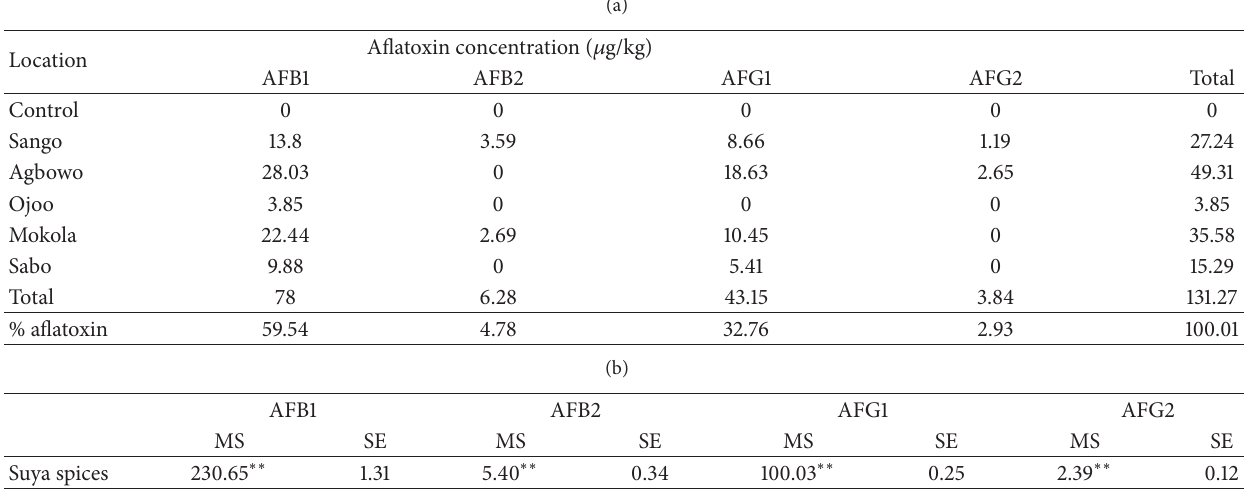
Table 2: Aflatoxin concentration of “Suya spices” samples collected from locations in Western